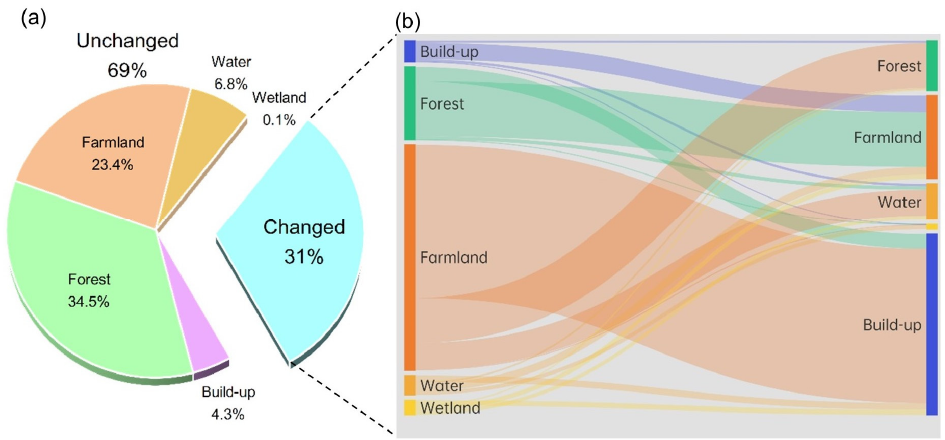
Figure 8. Land use types and their conversion in the HGBA during 1995–2020: ( a ) proportion for changed and unchanged (forest, farmland, built-up, and water) land use types; ( b ) Sankey diagram illustrating the flow and area for land use conversions.